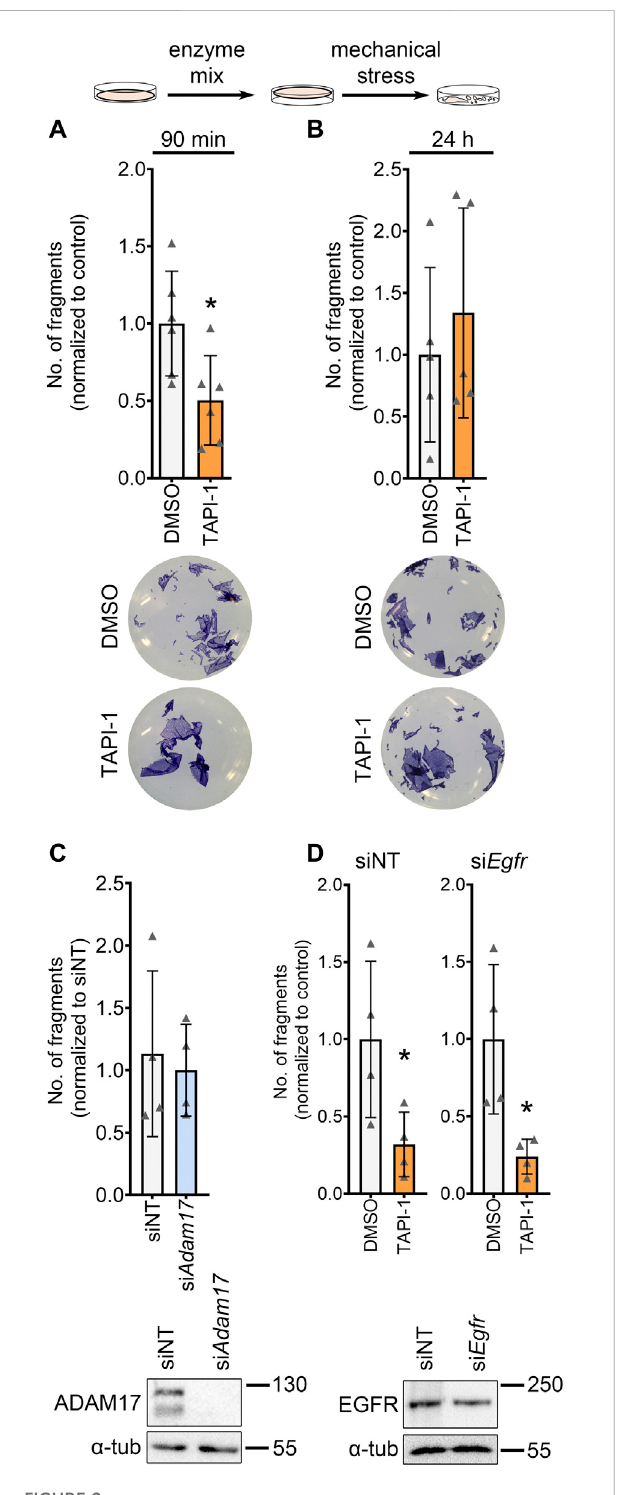
FIGURE 2 (Continued) HL-1 cardiomyocytes after knockdown of Egfr by siRNA and treatment with TAPI-1 for 90 min. Knockdown ef fi ciency was con fi rmed by Western blot, representative images are shown below the